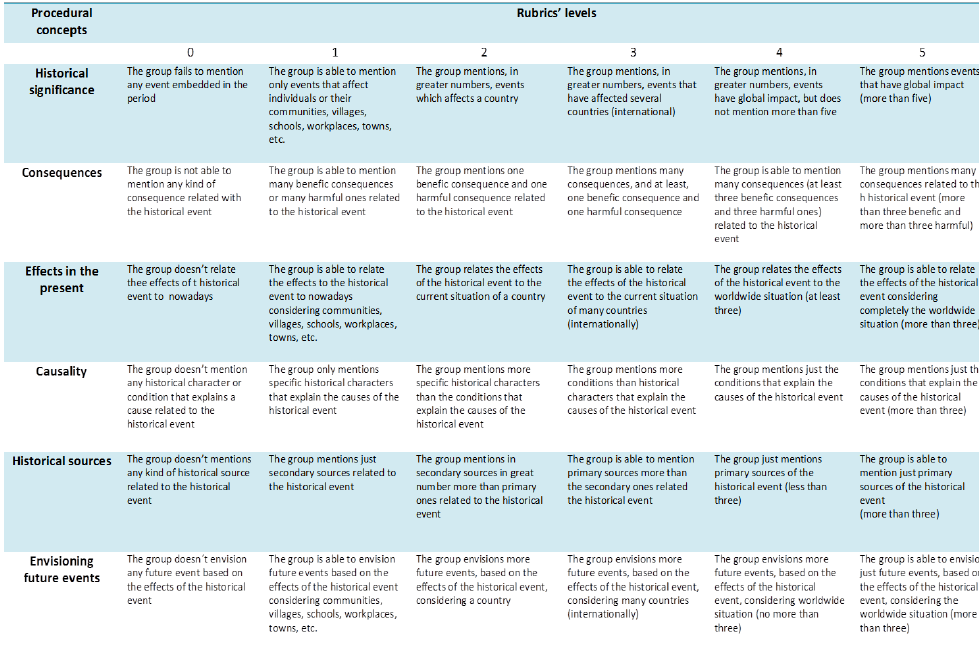
Figure 2 : Levels of the rubrics that show the progression of ideas for each procedural